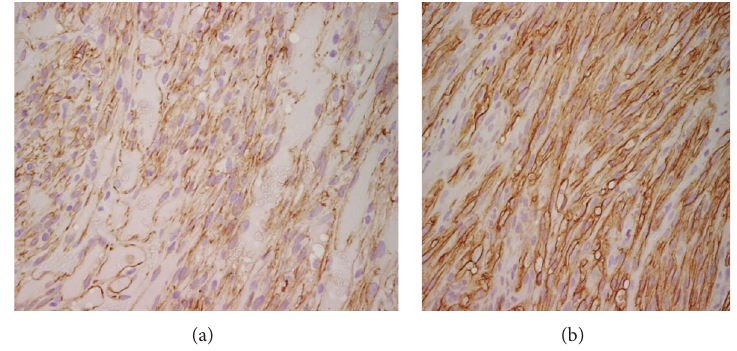
Figure 3: Immunohistochemistry (a) CD31, (b)